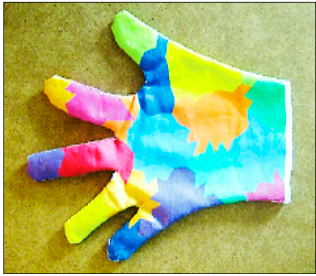
Figure 5. Color-based recognition using glove marker [13].